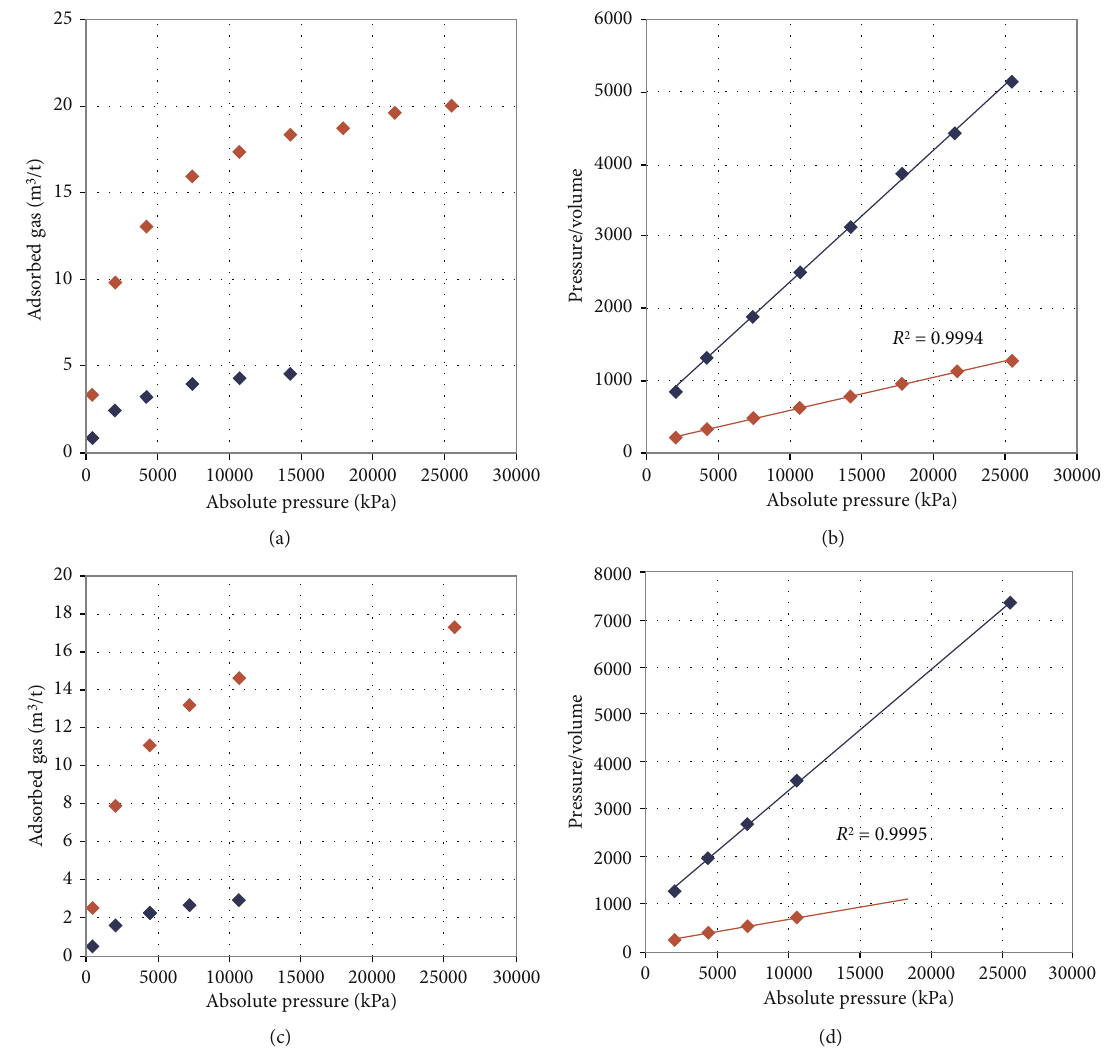
Figure 11: (a, b) Shows the methane adsorption capacity with high pressure in the SF, 2144.99m. (c, d) Shows the methane adsorption capacity with high pressure in the TF,